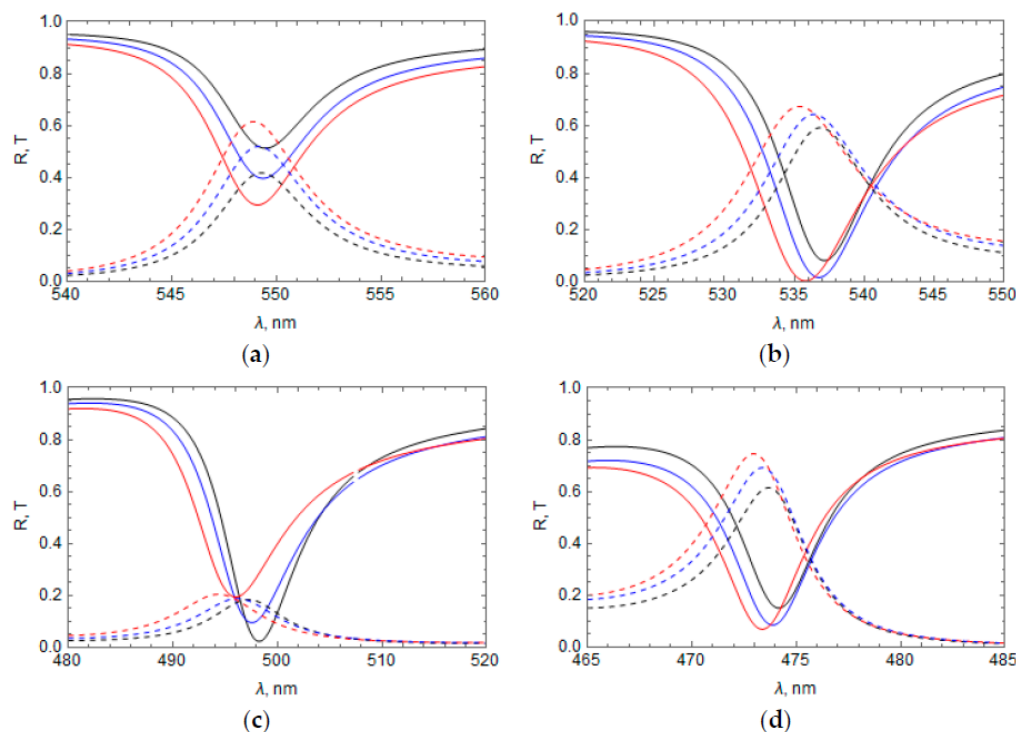
Figure 4. Influence of the refractive index of the medium above the Ag layer, n 1 , on the reflectance and transmittance: n 1 = 1 (black line), 1.5 (blue), and 2.5 (red); ( a ) TPP band 1; ( b ) TPP band 2; ( c ) TPP band 3; ( d ) TPP band 4. Reflectance—Solid lines, transmittance—Dashed lines, thickness of the Ag layer = 35 nm.